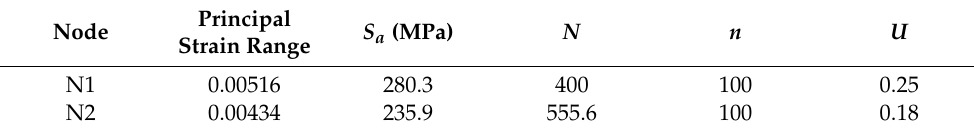
Table 7. Simulated results of cyclic elastoplastic fatigue analysis.